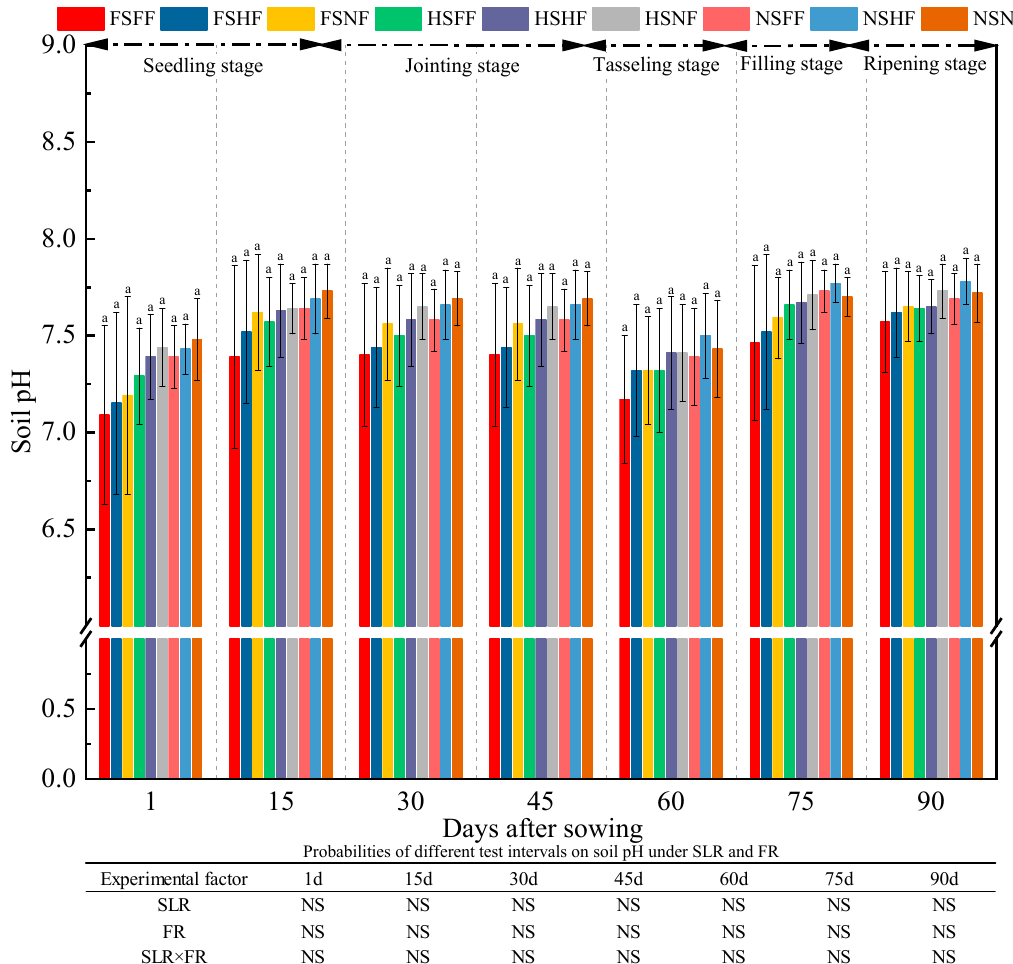
Figure 14. Effects of SLR and FR on the soil pH. Note: Bars represent means ± standard deviation ( n = 3) with different letters indicating significant differences based on LSD ( p ≤ 0.05). SLR, sugarcane leaf return; FR, fertilizer reduction.